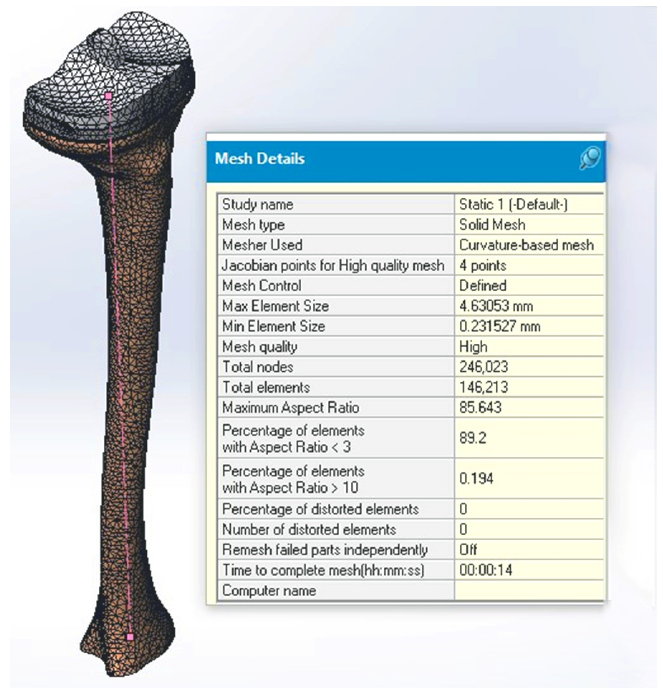
Figure 6. Tibial bone–implant model.